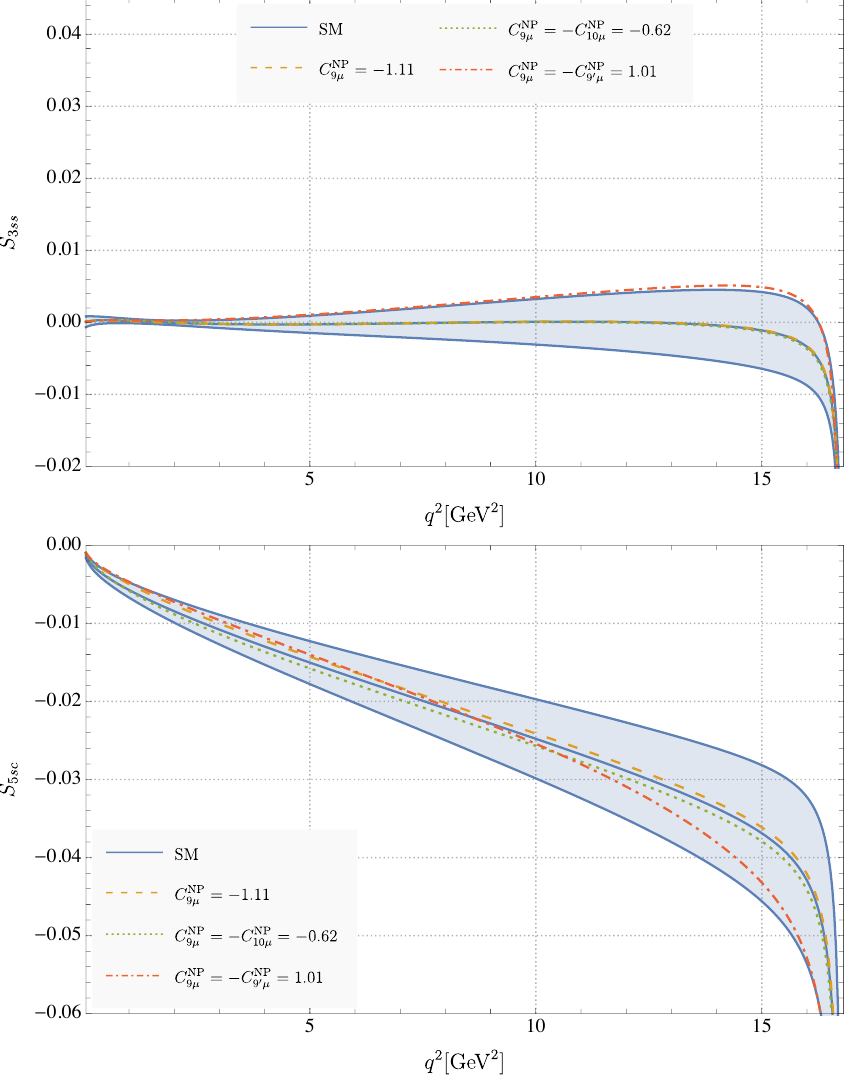
Figure 4 . Variation of S 3 ss (top) and S 5 sc (bottom) with respect to the dilepton invariant mass, in the case of the SM and three NP models.